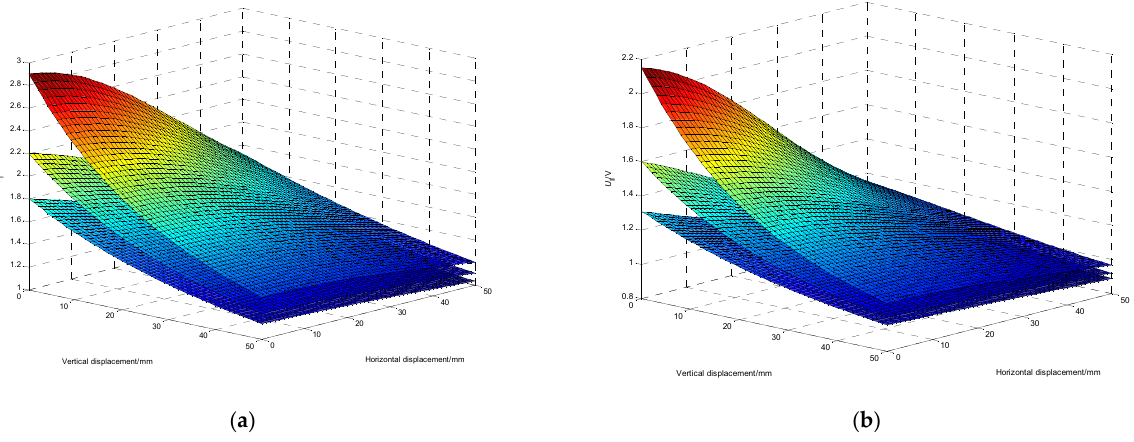
Figure 7. Three-dimensional graph of ( a ) type I mutual inductance voltage, ( b ) type II mutual inductance voltage versus horizontal displacement and vertical displacement at different inter-axis angles. (10 ◦ , 30 ◦ , and 50 ◦ from top to